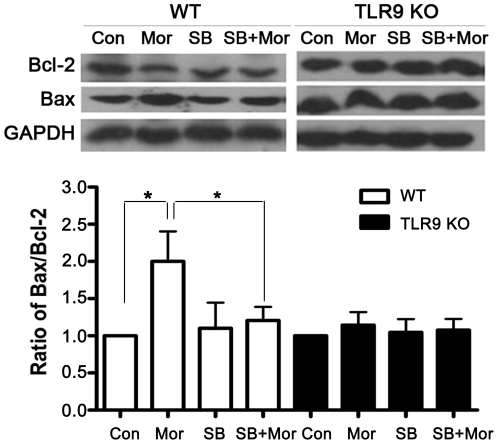
Blockade of p38 MAPK by SB203580 inhibits morphine-induced changes in
Bcl-2 and Bax expression levels.WT microglia were exposed to SB203580 (SB) at 10 µM and then
treated with morphine at 10 µM for 24 hr. The expression of Bax
and Bcl-2 was examined by Western blot analysis. Representative results
of the levels of Bcl-2 and Bax are shown of each pane. Mean values were
derived from three independent experiments. *
p<0.01 compared with indicated groups.